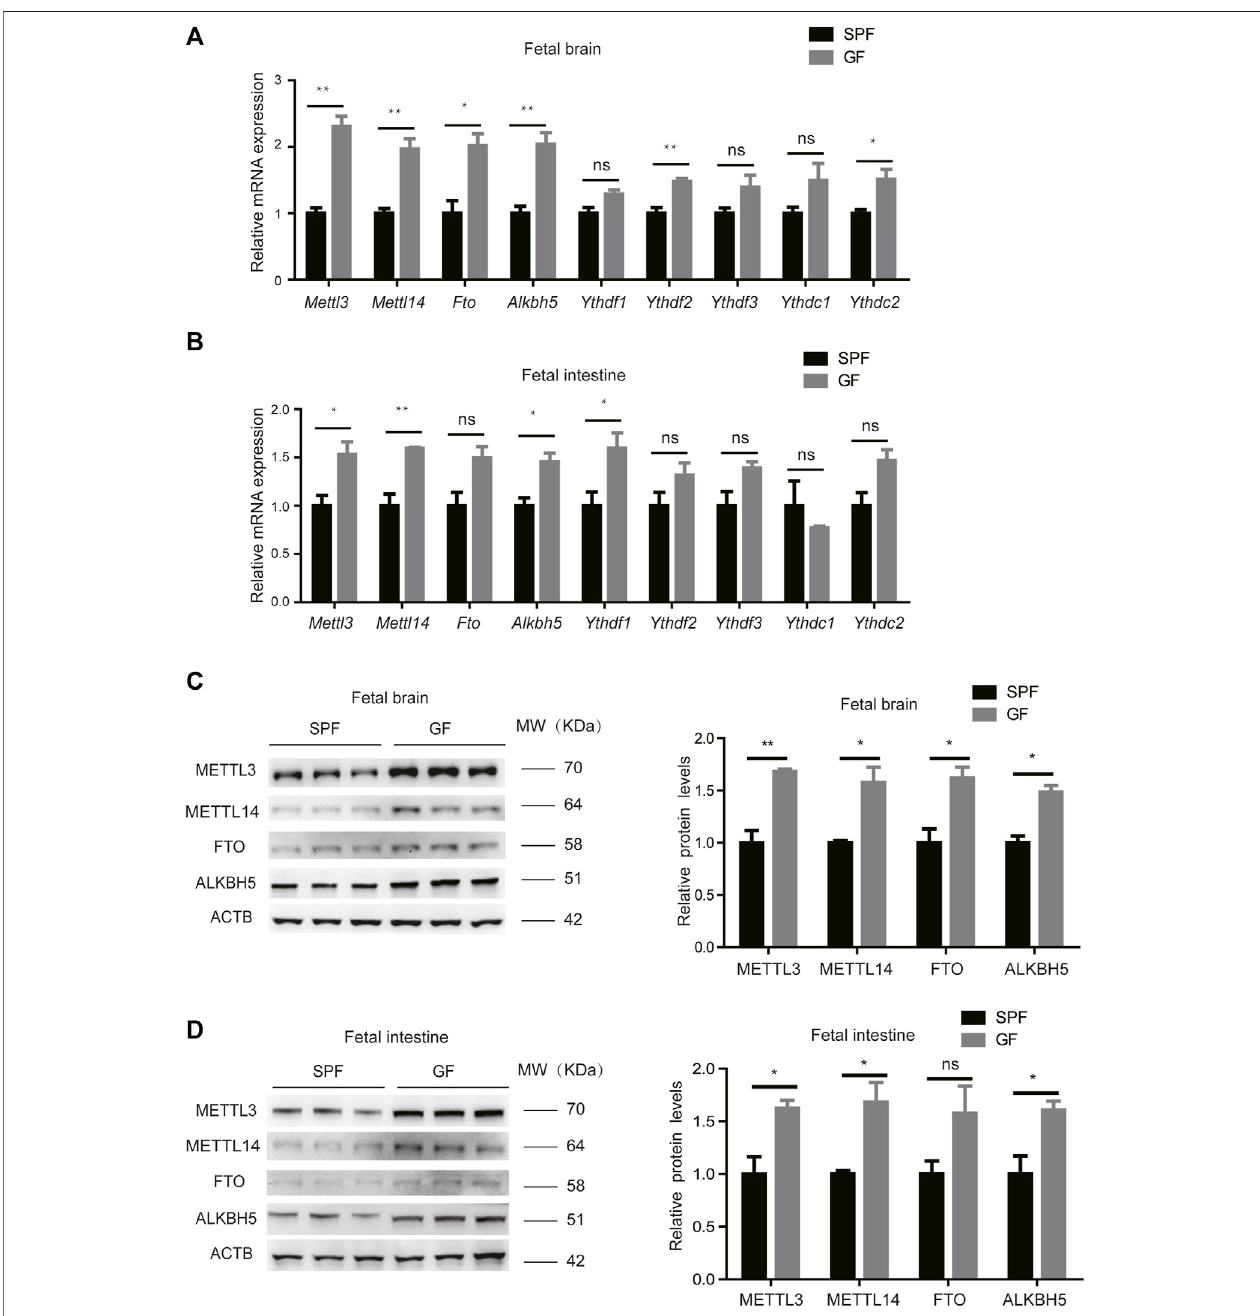
FIGURE 1 | Loss of the maternal microbiome alters the expression of m 6 A writers and erasers in fetal mice. (A,B) Relative mRNA expression levels of m 6 A writers, erasers, and readers in fetal brains (A) and intestines (B) of SPF and GF mice. (C,D) Western blots showing the protein expression of m 6 A writers and erasers in fetal brains (C) and intestines (D) of SPF and GF mice, and relative protein expression levels were calculated based on the band density in Western blotting results.